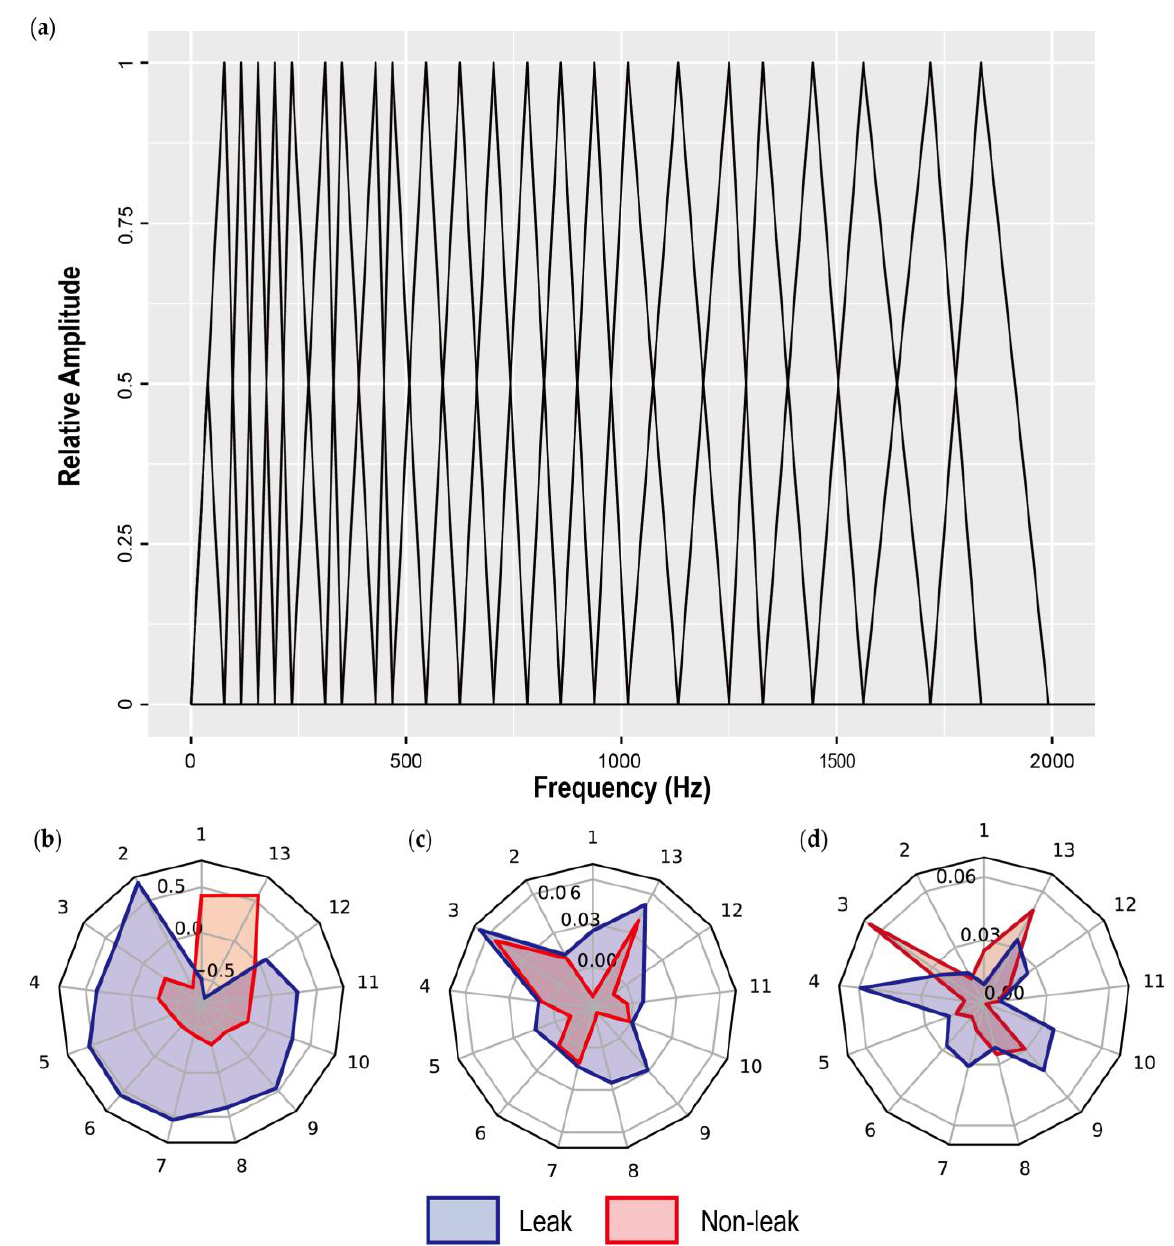
Figure 1. Mel filters and the average MFCCs’ features’ responses: ( a ) The triangular filter banks with Mel frequency. The number of filter banks is 24; ( b ) The average value of original MFCCs’ features for leak and non-leak signals; ( c ) The same as ( b ), but using the first-order derivative of MFCCs’ features; ( d ) The same as ( b ), but using the second-order derivative of MFCCs’ features. Tables 1 and 2 describe the selected frequency- and time-domain features,